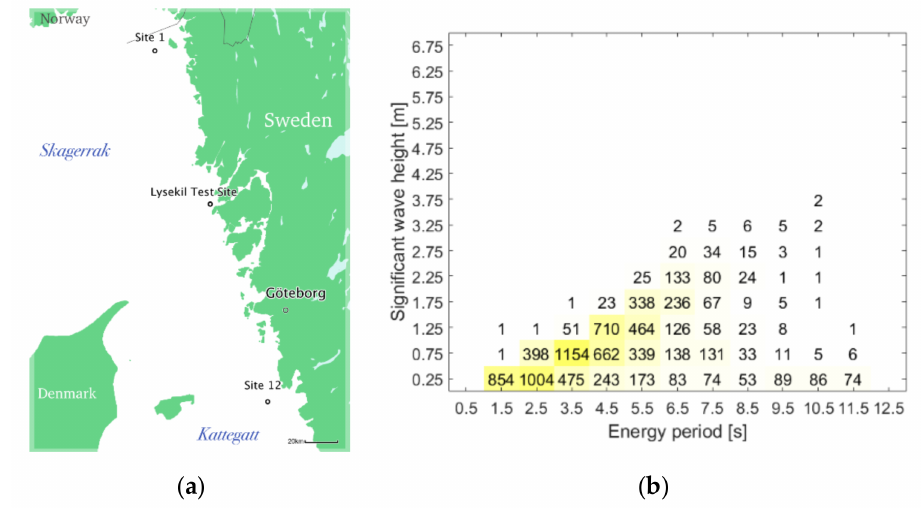
Figure 2. ( a ) Map presenting the location of the Lysekil test site and other research sites [36]. In the map, Site 1 and Site 12 were the chosen research sites for our study; ( b ) scatter diagram for significant wave height and energy period at the Lysekil test site.